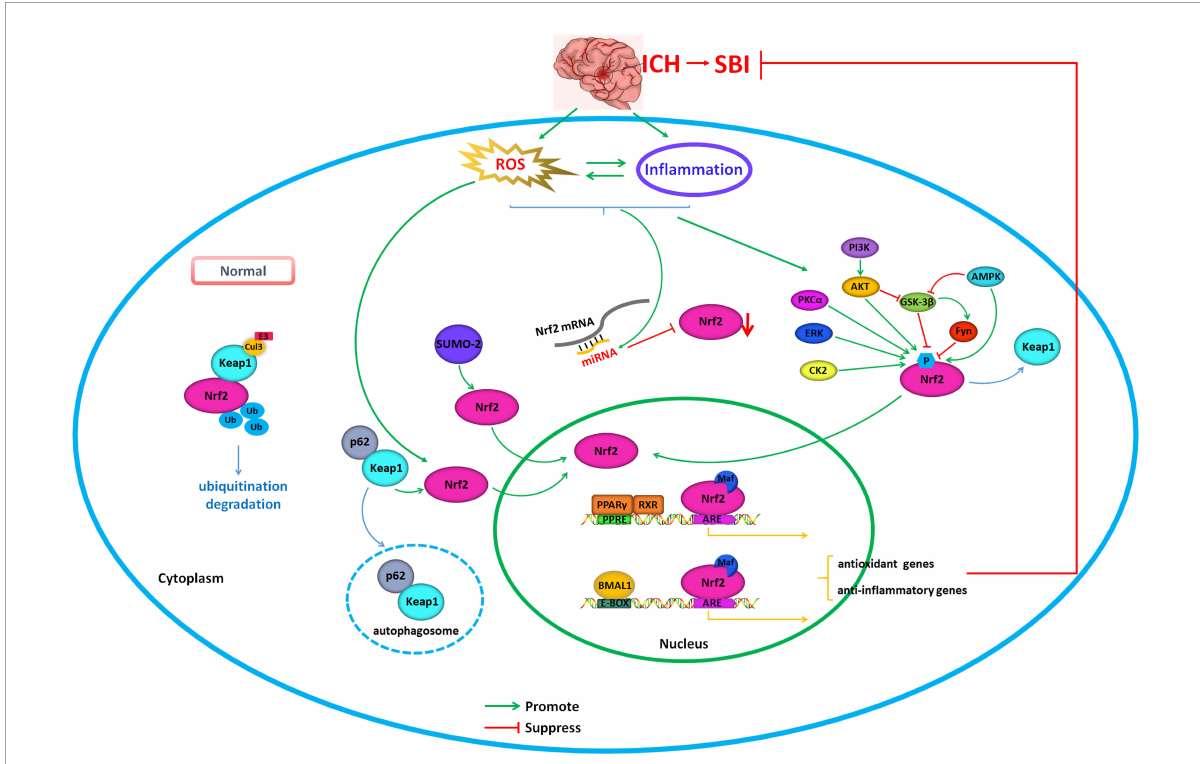
FIGURE1 Regulation of Nrf2 as the potential therapeutic target in intracerebral hemorrhage. Under normal physiological conditions, Nrf2 interacts with Keap1 and is anchored in the cytoplasm. Keap1 serves as a substrate for Cul3/Rbx1 E3 ubiquitin, which can promote the ubiquitination of Nrf2 resulting in its rapid degradation from the proteasome, which serves to maintain Nrf2 levels. During conditions that produce oxidative stress, including excessive production of ROS, Nrf2, and Keap1 disconnect, and Nrf2 translocates into the nucleus. There, Nrf2 can coordinate anti-oxidative stress and anti-inflammatory processes by means of AREs that are located in target gene regulatory regions. The activity of Nrf2 can be controlled by regulating gene expression, protein stability, subcellular localization, and synergistic effect with other transcription factors. Green arrows indicate promotion of Nrf2 translocation into the nucleus and activation. Red arrows indicate suppressing of Nrf2 translocation into the nucleus and inhibition of its